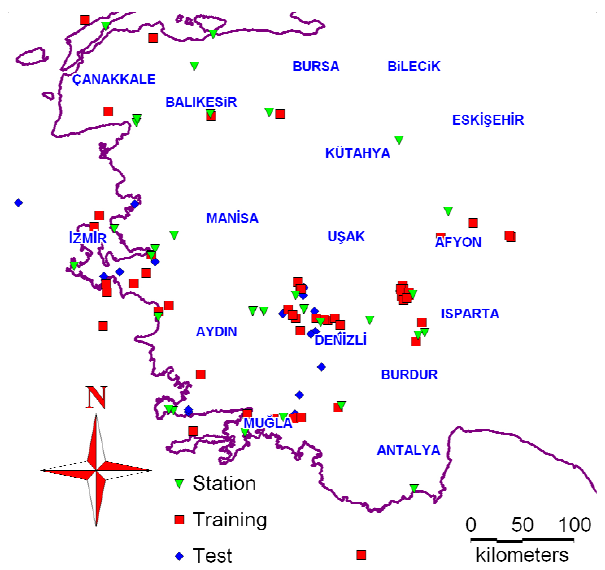
Fig. 2. Strong motion epicentres and Recording stations. Figure 2. Strong motion epicenters and Recording stations